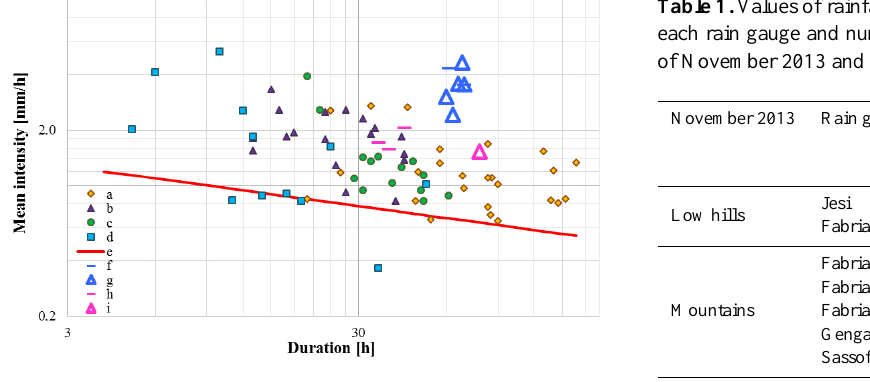
Figure 2. Intensity–duration logarithmic graph modified according to Gioia et al. (2015). Figure shows the comparison between the ID values of historical rainfall events (a–d) , the ID threshold (e) and the ID data of the November 2013 (f, g) and May 2014 (h, i) rain- falls. The historical rainfall events are represented according to the number of landslides triggered: (a) main events that triggered more than 10 landslides, (b) secondary events that triggered 3–9 land- slides, (c) minor events that triggered 2 landslides, and (d) single events that triggered 1 landslide. The ID data of November 2013 and May 2014 are differentiated according to the rain gauge loca- tions: low hills (f, h) or mountains (g, i) .